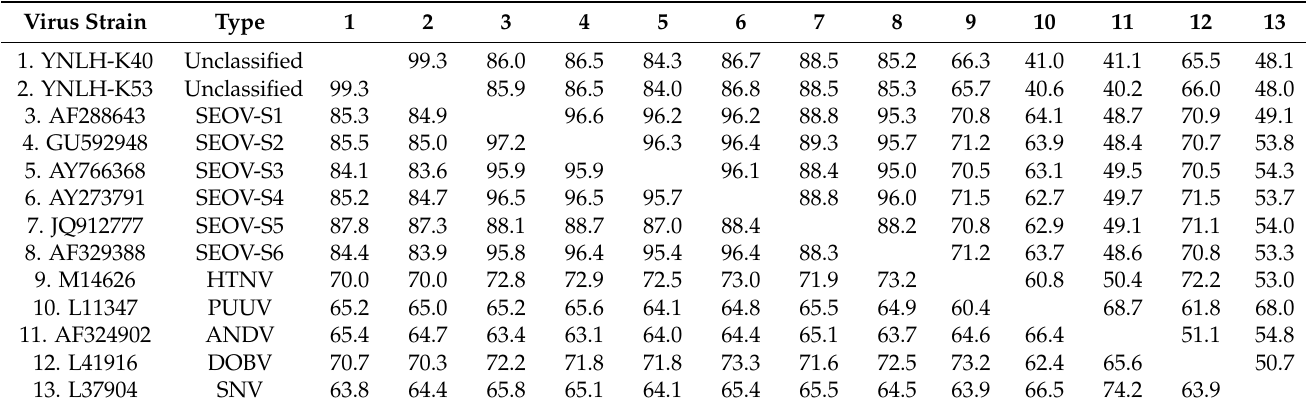
Table 2. Comparison of nucleotide and amino acid homologies of HV in Yunnan Province with other genotypes and